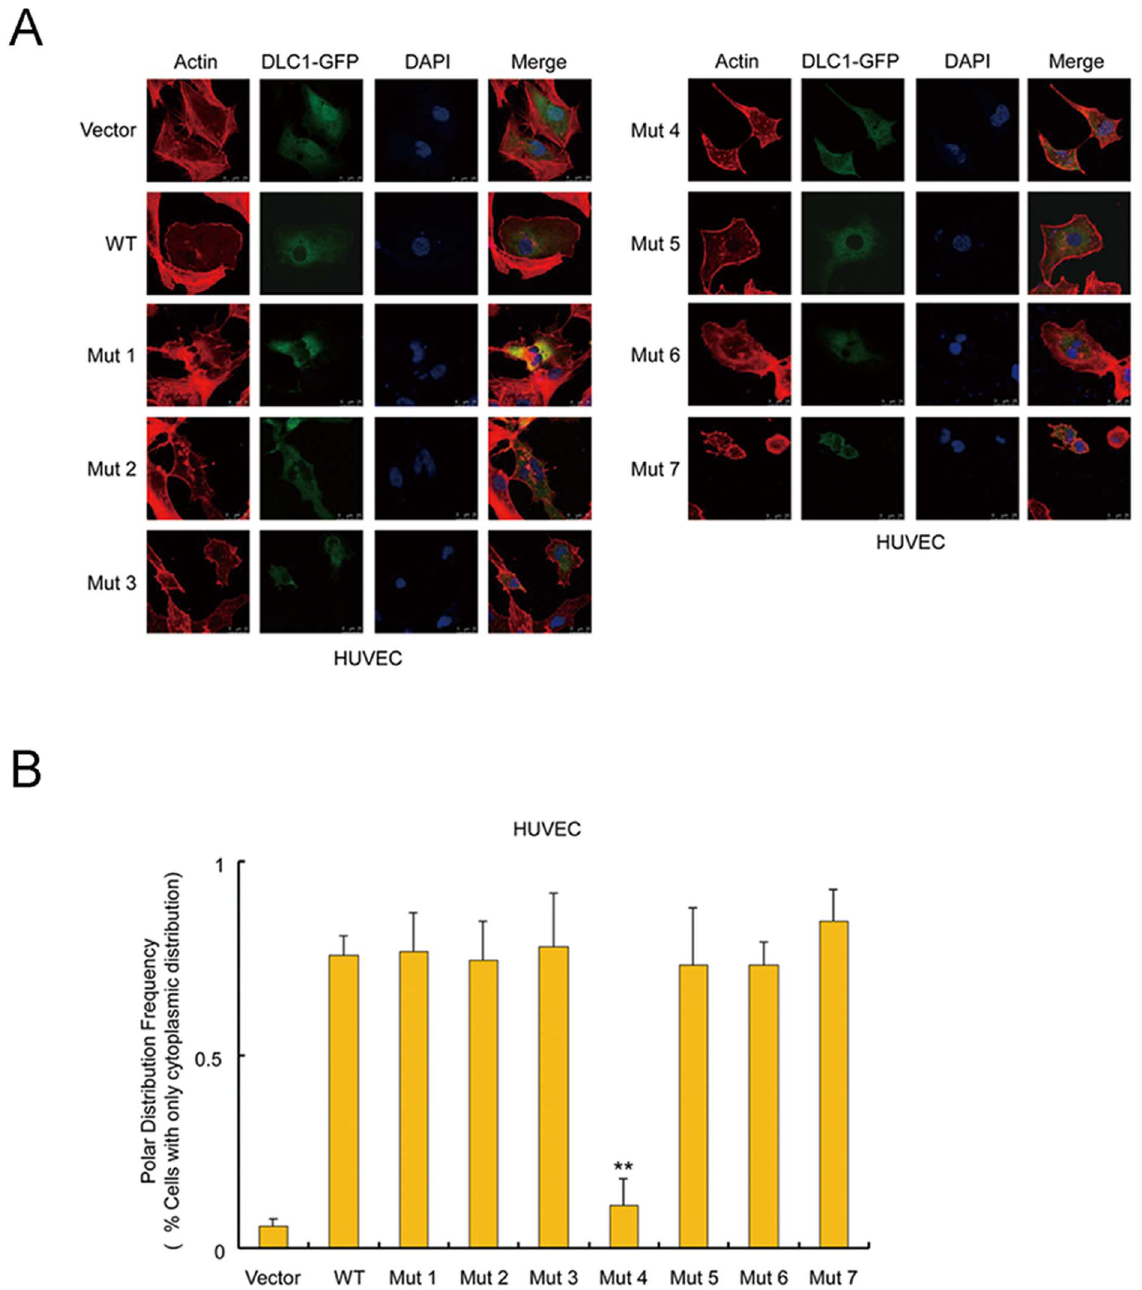
Figure 3. The subcellular localization of wild-type DLC1 and mutants in HUVECs. (A) Images of wild-type and mutant DLC1 distribution in HUVECs using laser scanning confocal microscopy. (B) The percentage of cells with wild-type and mutant DLC1 proteins with exclusive cytoplasmic- localization. Mutant 4 showed a significant difference from the wild type, as opposed to the control vector. *Student’s t-test P v 0 : 05 ; ** P v 0 : 01 . Scale bar, 25 m m. Ns, not significant.